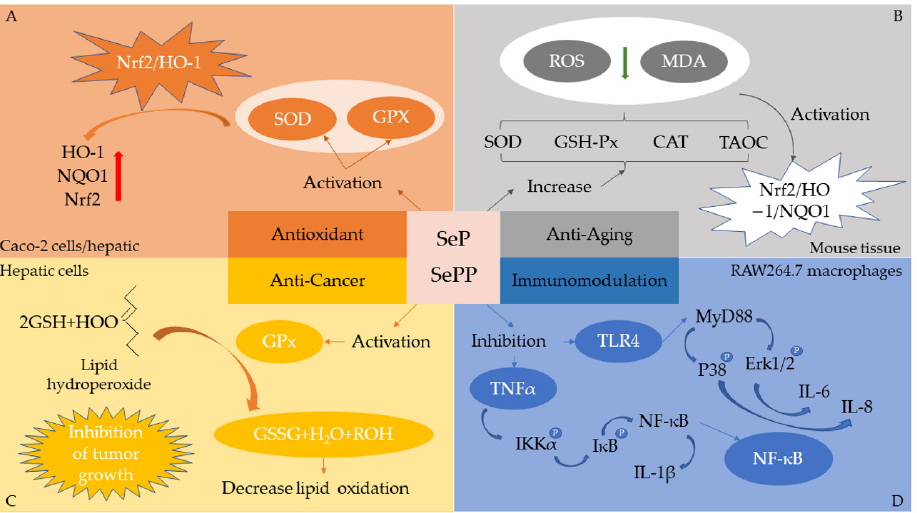
Figure 2. Bioactivities and related mechanisms of plant Se-enriched proteins/peptides [92–95]. ( A ) SePs has antioxidant potential via modulation of the NRF2 − HO-1 signaling pathway. The soybean SePs can activate the Nrf2 pathway, leading to increases in superoxide dismutase (SOD) and glutha- thione peroxidase (GPX), which are crucial for the reduction of oxidative stress. ( B ) SePPs have anti- aging properties by activating the Nrf2/HO-1/NQO1 pathway. The Cardamine violifolia SePPs allevi- ate reactive oxygen species (ROS) and malonaldehyde (MDA) levels by increasing the activities of SOD, glutathione peroxidase (GSH-Px), catalase (CAT), and total antioxidant capacity (TAOC), and they activate the Nrf2/HO-1/NQO1 pathway, which probably represents the antiaging mechanism of the SePPs. ( C ) Antioxidant protection of lipids through GPx to reduce the growth of tumor. Se- enriched chickpea sprouts increased GPx activities, cholesterol, triglycerides, and low-density lipo- protein cholesterol levels to decreased significantly the tumor growth. ( D ) The regulation of NF- κ B and MAPK signaling pathways by SePPs in Pb 2+ -induced RAW264.7 macrophages cells. The rice SePPs decreased the secretion levels of proinflammatory cytokines TNF- α , NF- κ B, IL-1 β , MyD88, IL-6, and IL-8, downregulated the expressions of I κ B, IKK α , p38, and Erk1/2, and blocked the phos- phorylation of these protein kinases to attenuate inflammatory response. Table 4. The Biological activities of plant Se-enriched proteins/peptides. Source